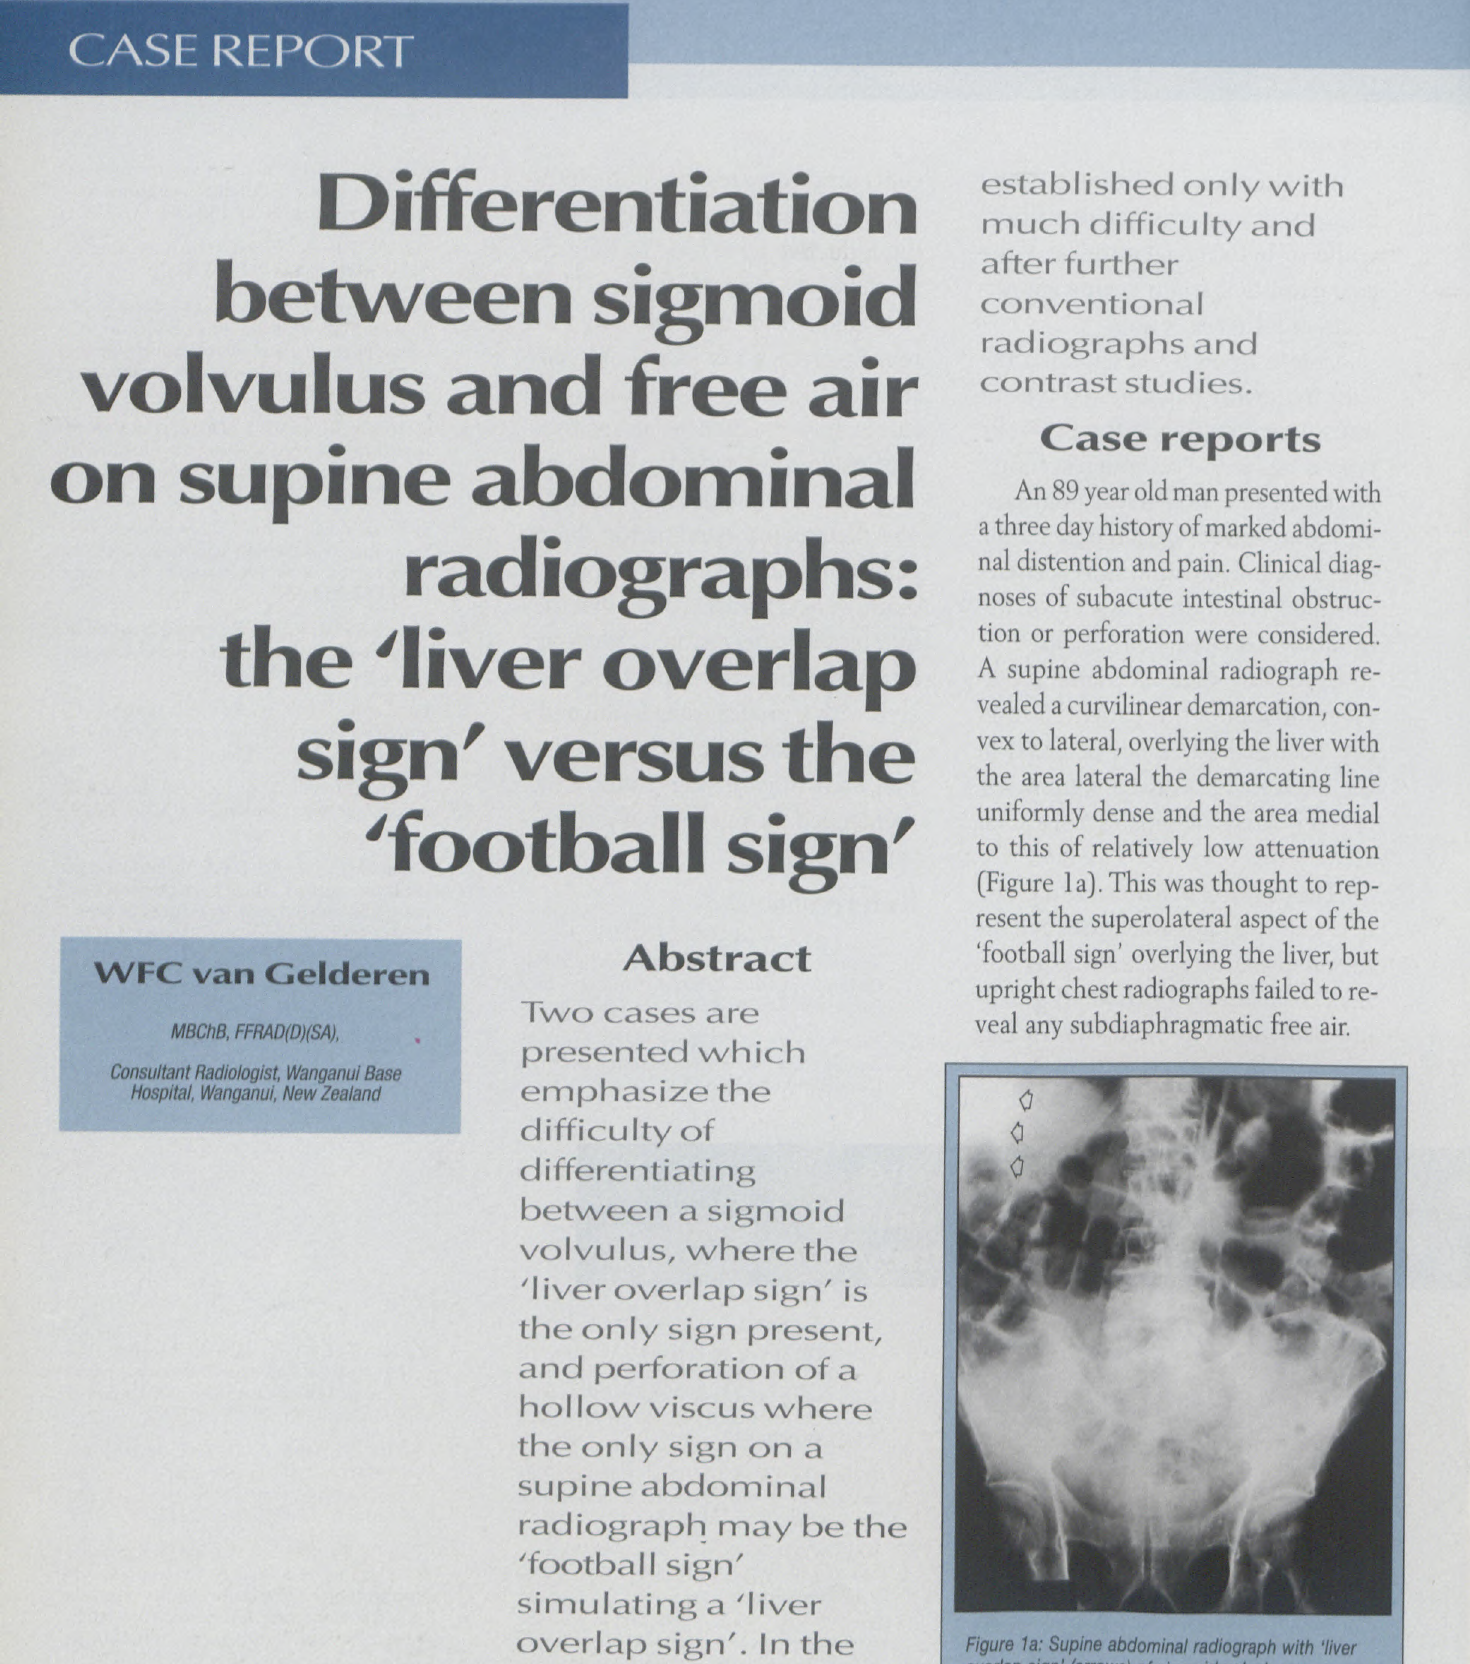
Figure 1a: Supine abdominal radiograph with 'liver overlap sign' (arrows) of sigmoid volvulus masquer- ading as 'football sign' of intraperitoneal free air. Confirmed as sigmoid volvulus (cf. Figure 1